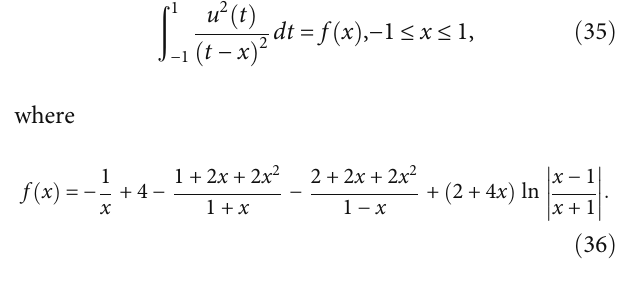
ð x Þ for Example 2